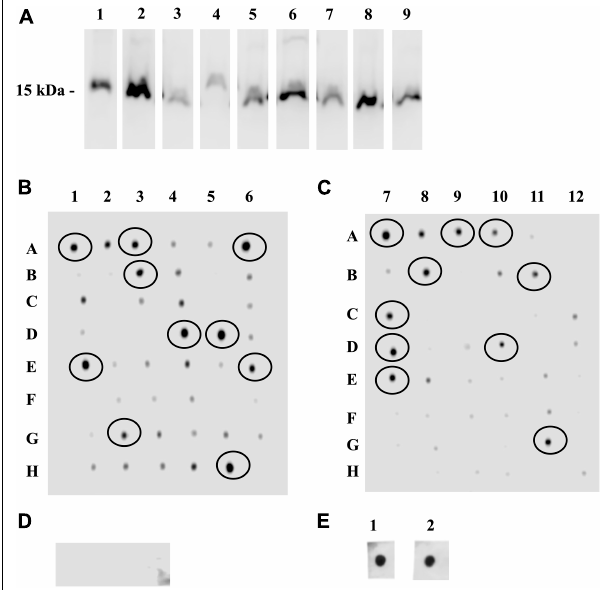
FIGURE 2 | Single-domanin antibodies (sdAbs) targeting rDIII and its interaction with the synthetic analogs of DIII-1 G299 − K307 and DIII-2 V371 − R388